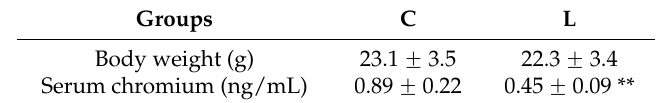
Table 3. Body weight, fasting blood glucose and serum chromium level in dams at weaning.